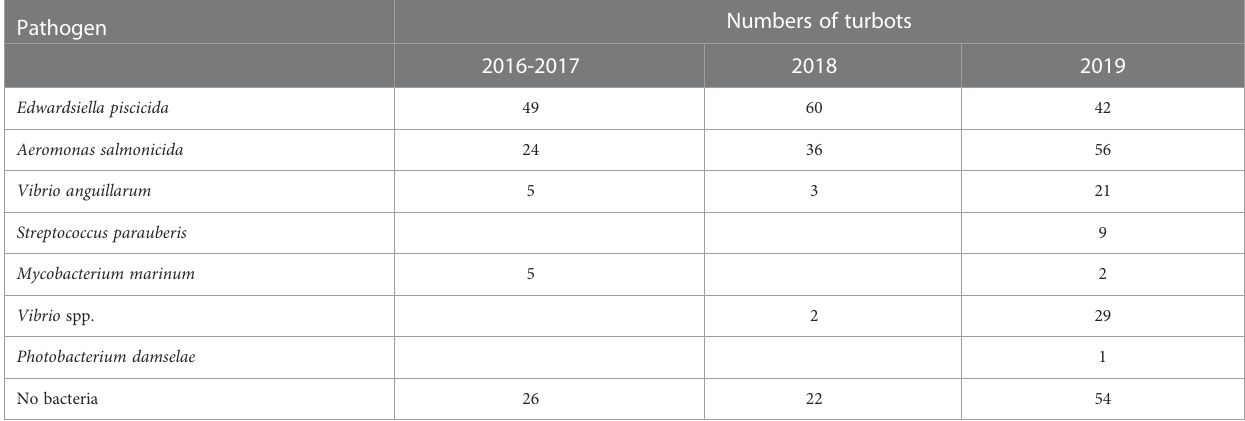
TABLE 1 Pathogens isolated from turbots from 2016 to 2019 (number of turbots).